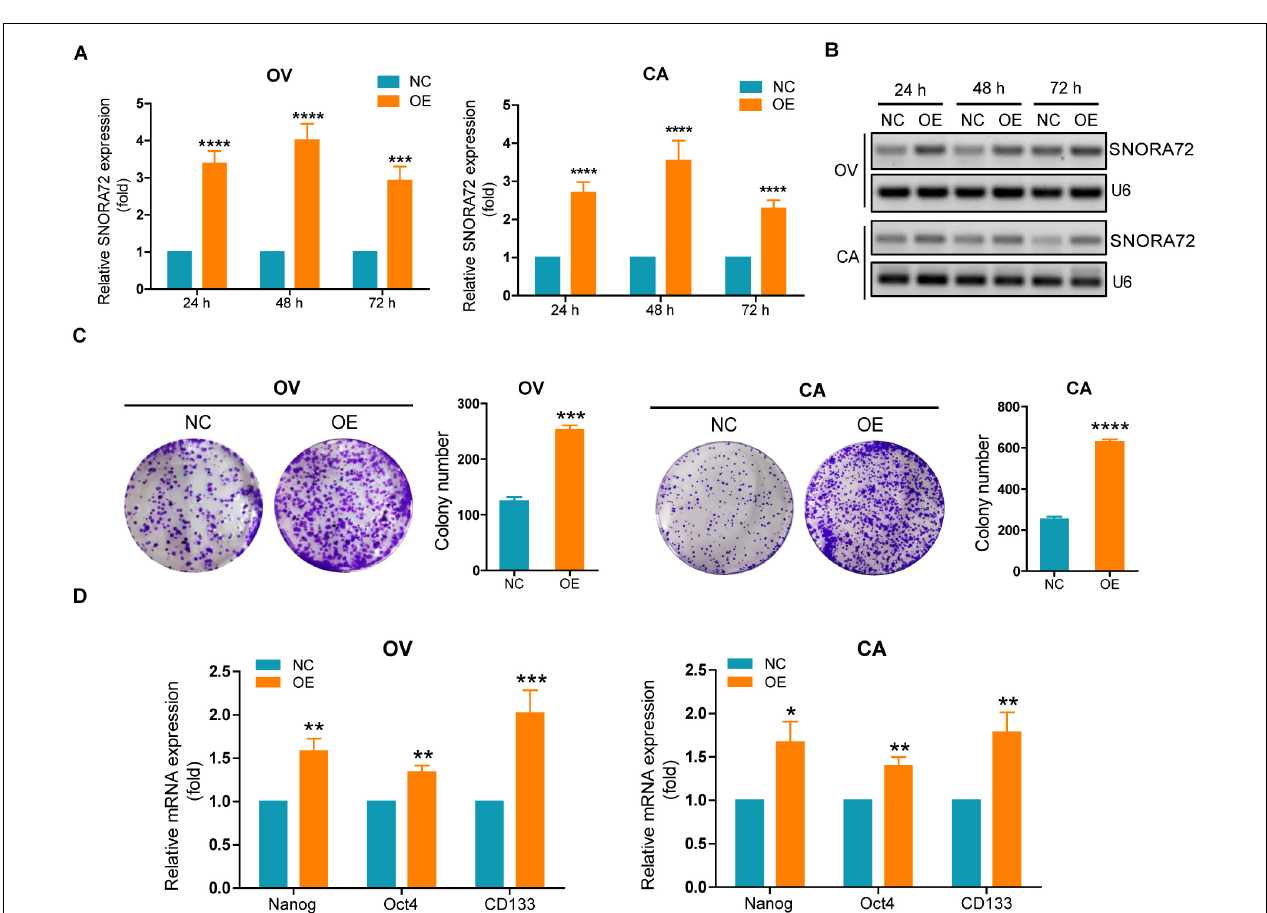
FIGURE 2 | SNORA72 overexpression increases the self-renewal of OVCAR-3 (OV) and CAOV-3 (CA) cells. Expression of SNORA72 determined in OV and CA ovarian cells at 24, 48, and 72 h after transfection of the SNORA72 overexpression (OE) or negative control (NC) plasmids by (A) quantitative reverse transcription PCR (qRT-PCR) and (B) RT-PCR analysis. (C) Changes of the clone performing ability detected by the plate clone formation assays in OV and CA cells transfected with the OE or NC plasmids. (D) Relative mRNA expressions of Nanog, Oct4, and CD133 to β -actin, as an endogenous control, analyzed by qRT-PCR in OV and CA cells after transfection of the OE or NC plasmids for 48 h. The expression level in OV and CA cells after transfection of NC plasmids was set as 1. * P < 0.05, ** P < 0.01, *** P < 0.001, and **** P < 0.0001.